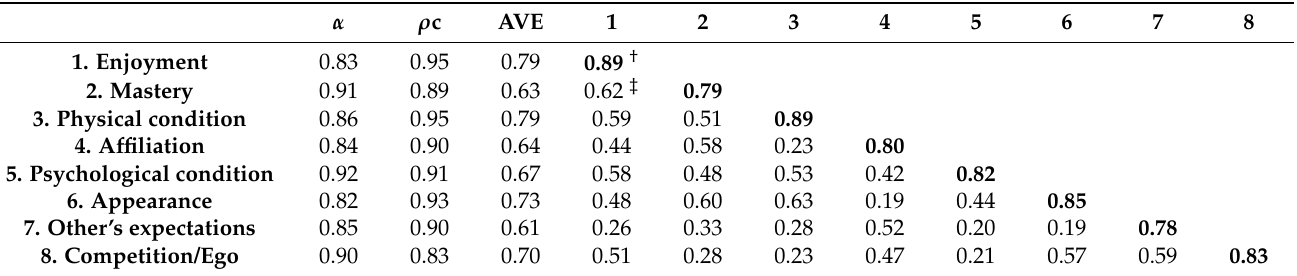
Table 3. Internal consistency, convergent validity and discriminant validity.